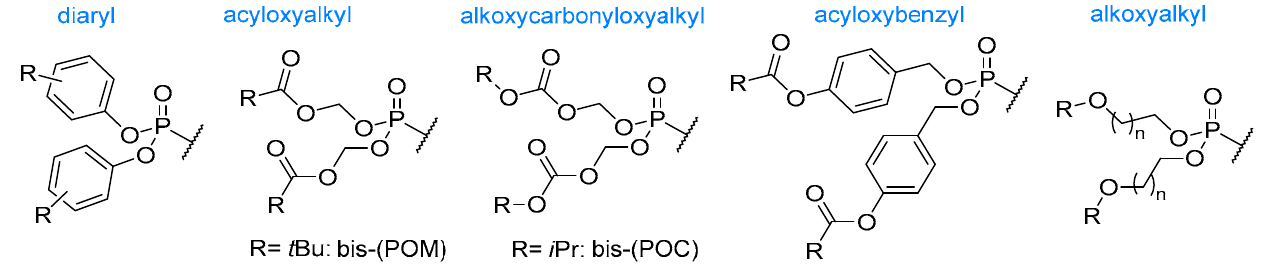
Figure 30. Lipophilic phosphonate prodrugs used for fosmidomycin and its analogs. 7.1.1. Ester Prodrugs of Fosmidomycin and